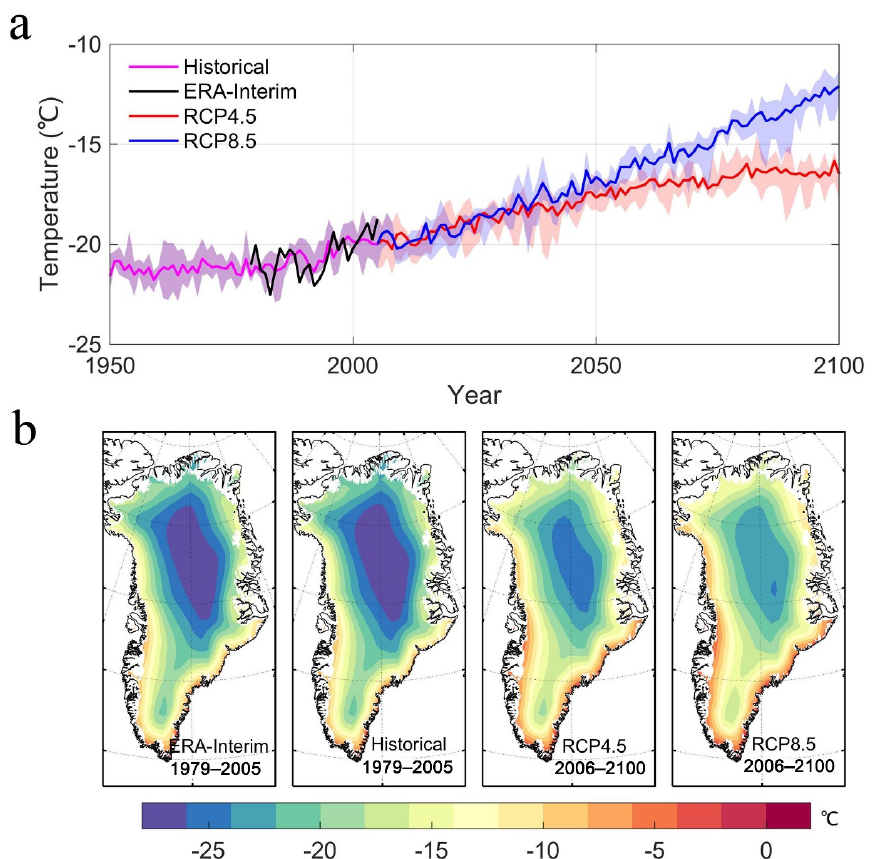
Figure 2. ( a ) Five-model ensemble mean annual near-surface air temperatures during 1950–2100 calculated from bias- corrected and downscaled ESM outputs under RCP4.5 (red) and RCP8.5 (blue) scenarios, and ERA-Interim data (black) for the period 1950–2005 (magenta). Colored shading indicates the across-model spread. ( b ) Maps of near-surface air temperature from ERA-Interim and downscaled ESMs for the period 1979–2005 under the RCP4.5 and RCP8.5 (2006–2100) scenarios.